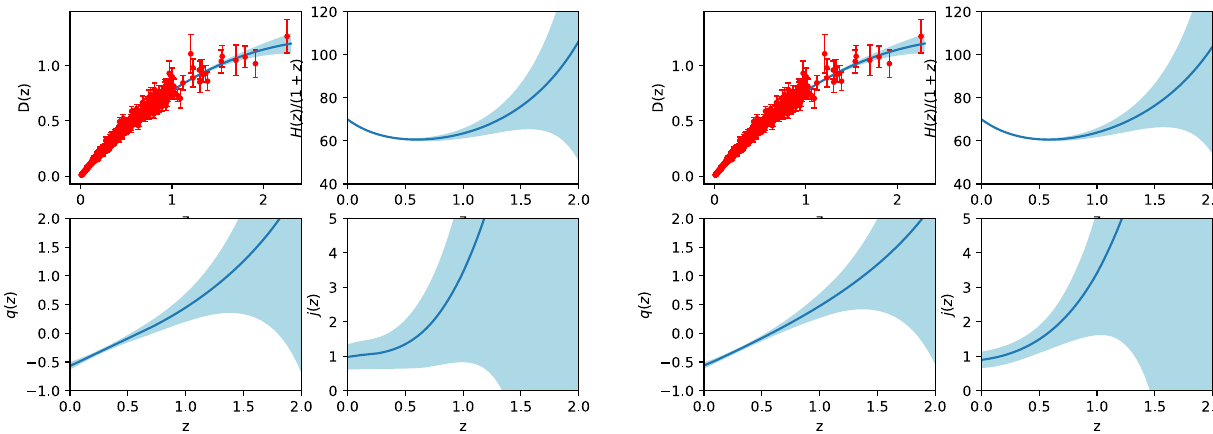
Fig. 2 Left panel: The cosmokinetic parameters as a function of redshift using Matern ( ν = 7 / 2) kernel for SNIa only data. Right panel: The cosmokinetic parameters as a function of redshift using Matern ( ν = 9 / 2) kernel for SN only data